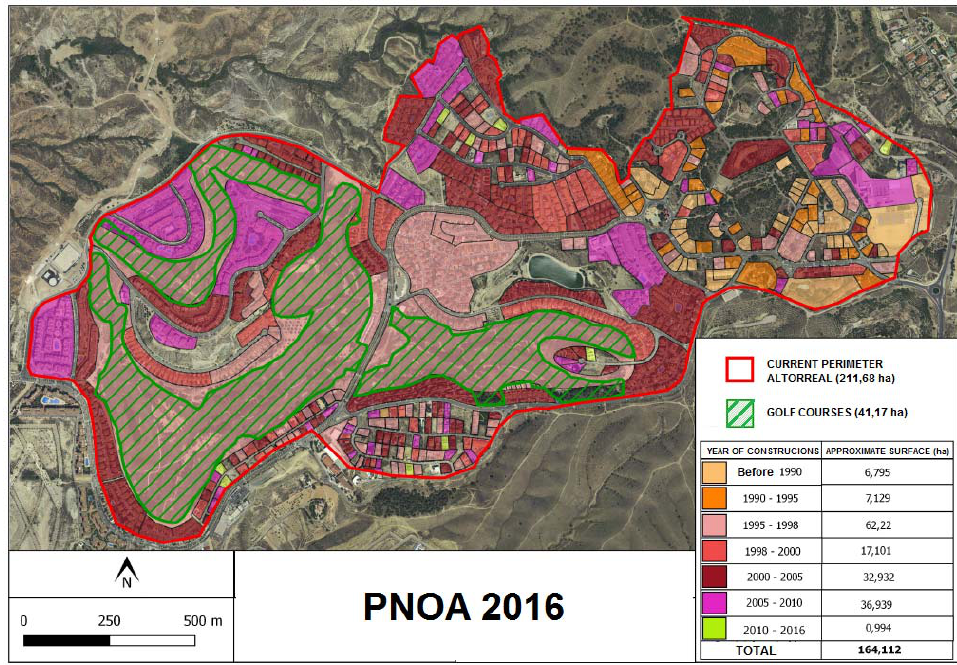
Figure 8. Evolution of the different projects of urbanization carried out in Altorreal.